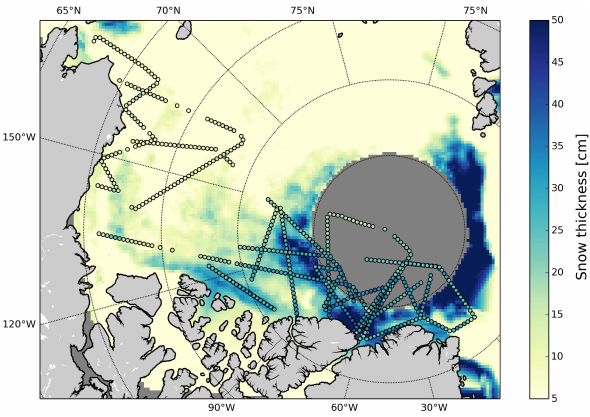
Fig. 10. Mean snow thickness field as retrieved from SMOS bright- ness temperatures averaged over 14–31 March 2012. The dots show IceBridge snow thicknesses, each averaged over 30km of flight dis- tance (if these contained at least 200 valid